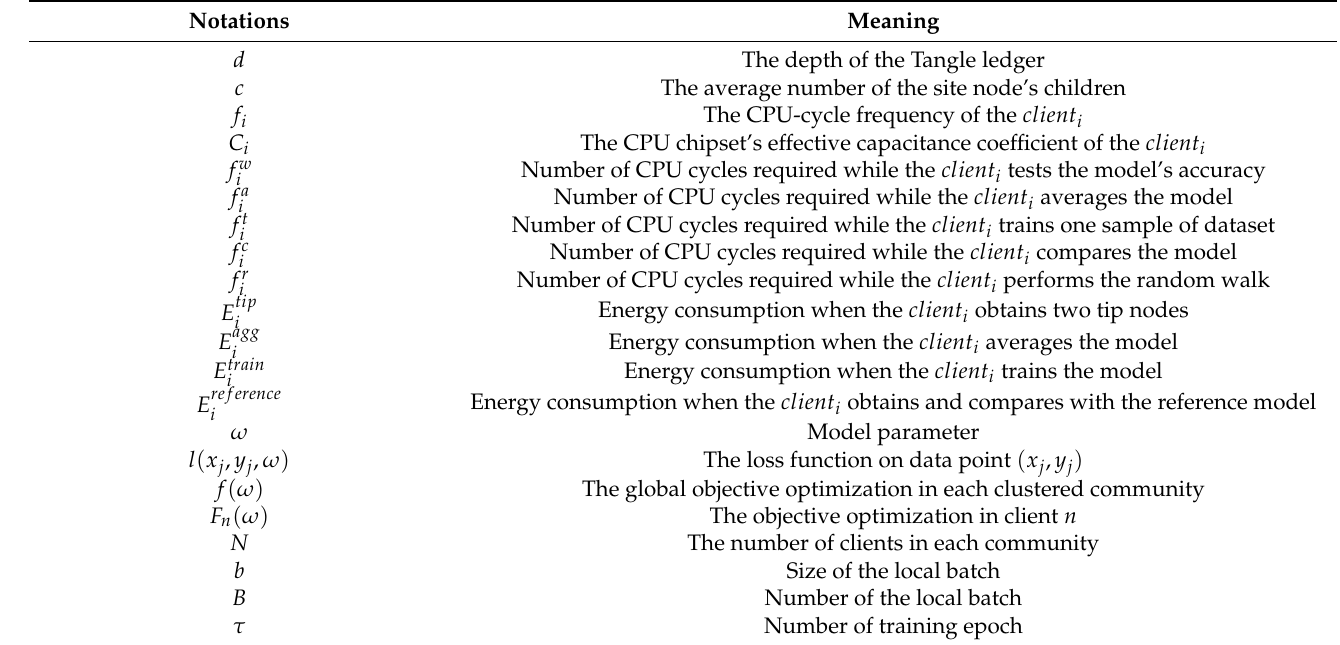
Table 2. Notations adopted for the energy consumption